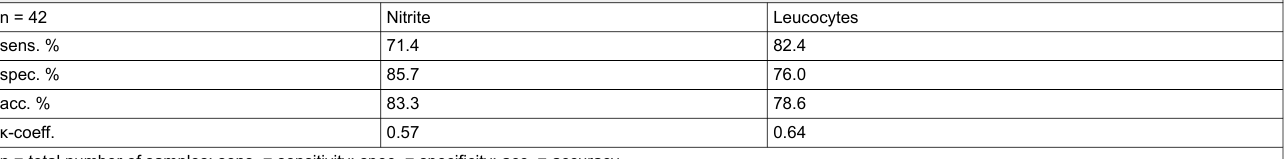
Table 1: Performance parameters of U-Test ® determined in the clinical study based on the reference of Combur 10 Test ® and Multistix ® 10 SG (both were used) and two consecutively collected urine samples for each